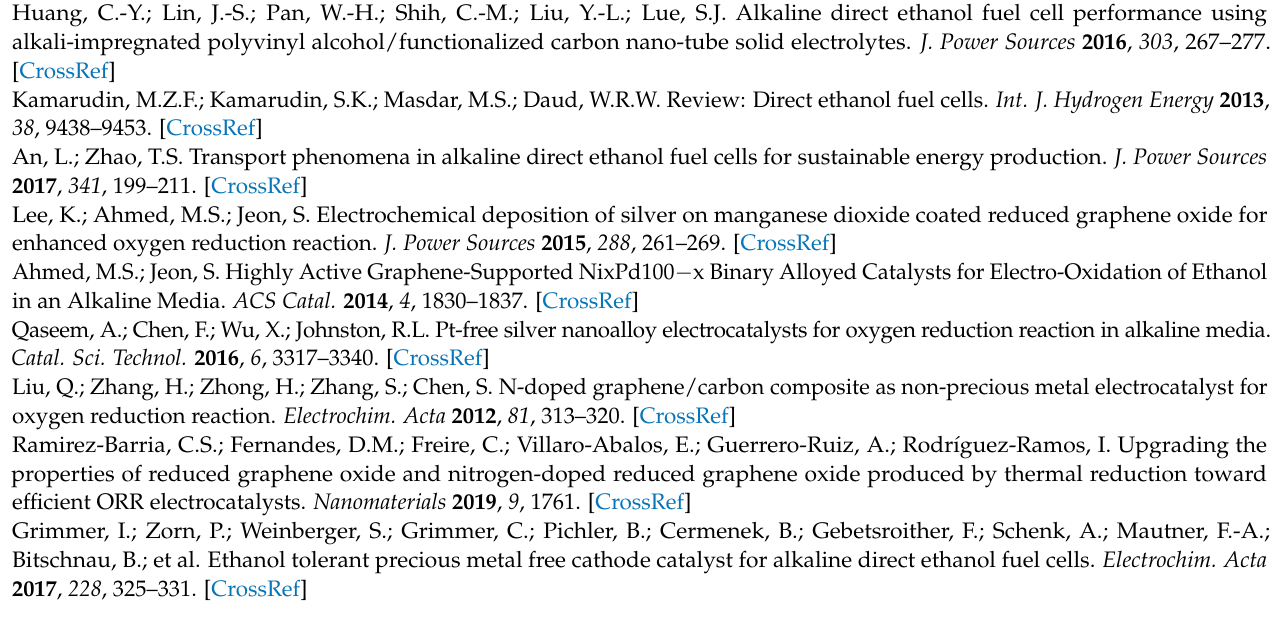
composites and Pt/C derived from the ORR curves in O 2 saturated 1 M KOH at 10 mV s − 1 at different rotation rates; Figure S6: Potentiodynamic ORR curves of Ag-Mn x O y /rGO (a) and Ag-Mn x O y /NGO (b) catalysts and blank support materials (c, d) in O 2 saturated 1 M KOH at 10 mV s − 1 at 1600 rpm with and without EtOH; Table S1: ICP-MS results of the Ag-Mn x O y /C catalysts; Table S2: Limiting current density of the graphene derivatives, Ag-Mn x O y /C composites and Pt/C catalysts without/with EtOH at different